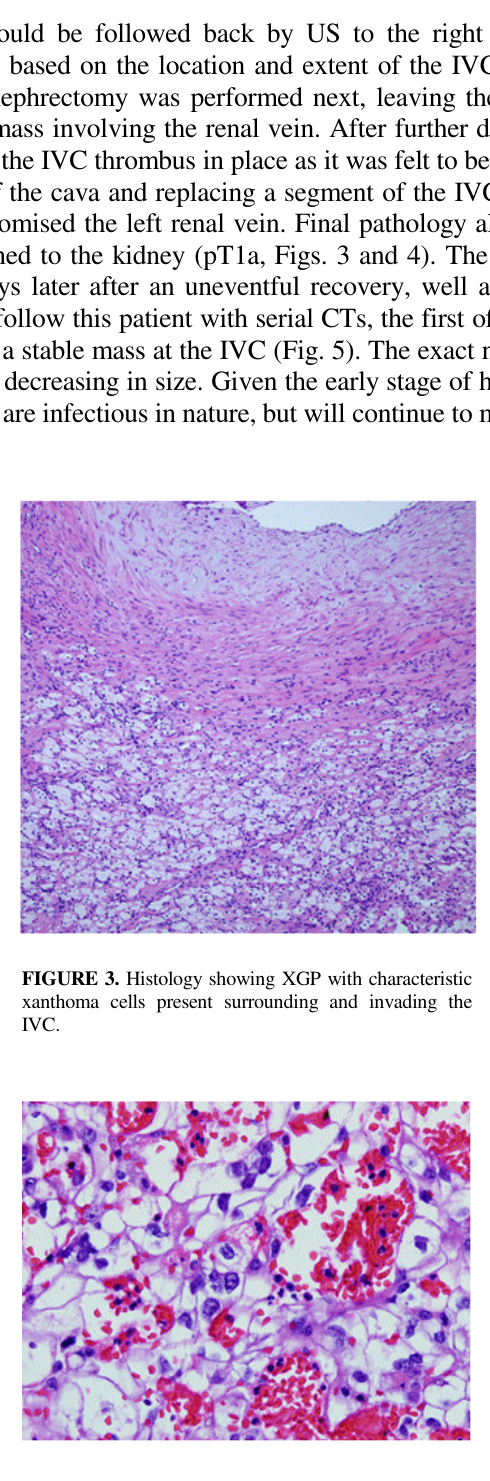
FIGURE 4. Histology showing conventional type clear cell RCC Fuhrman nuclear grade III with extensive